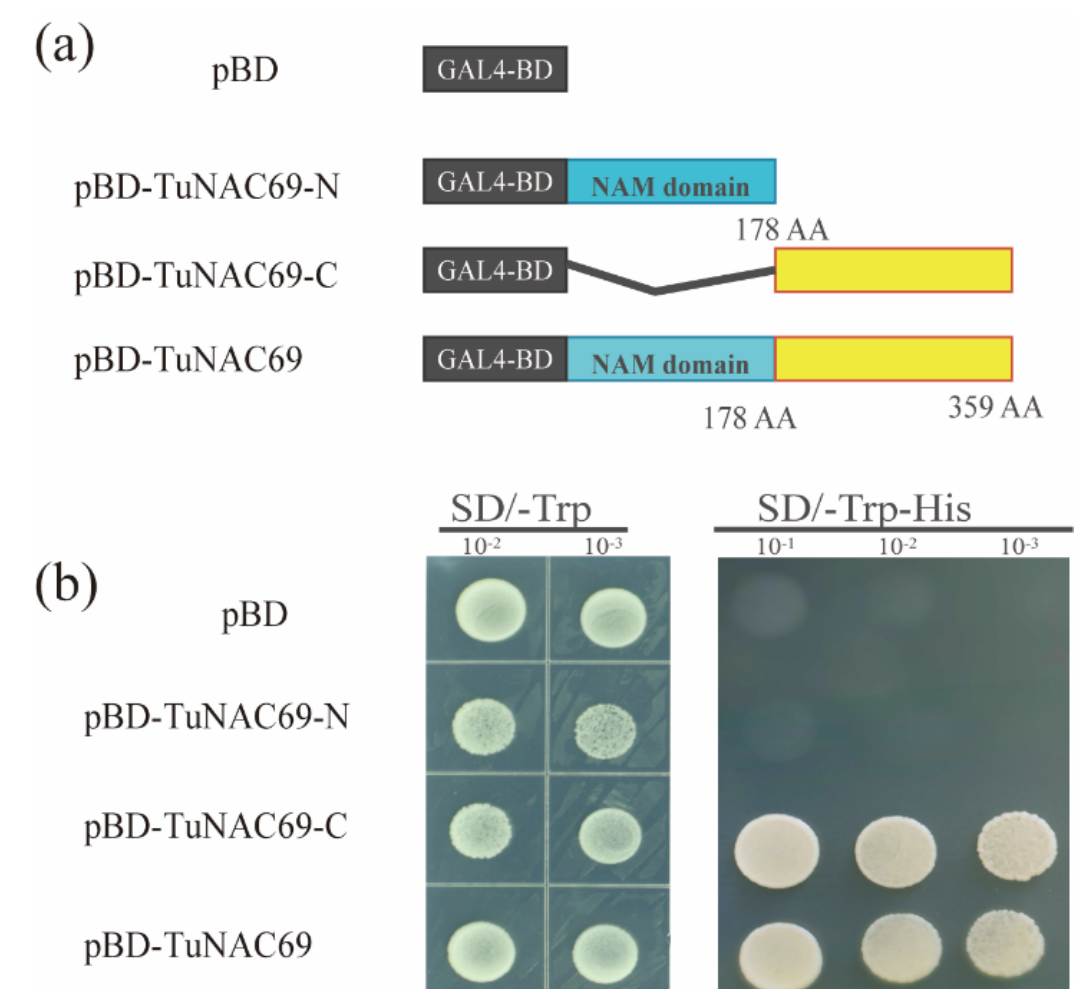
Figure 3. Subcellular localization of the TuNAC69 ‐ GFP fusion protein in wheat and tobacco. ( a ) TuNAC69 mainly localizes in the nucleus of T. aestivum cells. Bar = 100 μ m. ( b ) TuNAC69 localized in the nucleus of N. benthamiana cells. Bar = 50. ( c ) Accumulation of TuNAC69 ‐ GFP in N. bentham ‐ iana leaves by immunoblot analysis. The red triangle indicates TuNAC69 ‐ GFP.